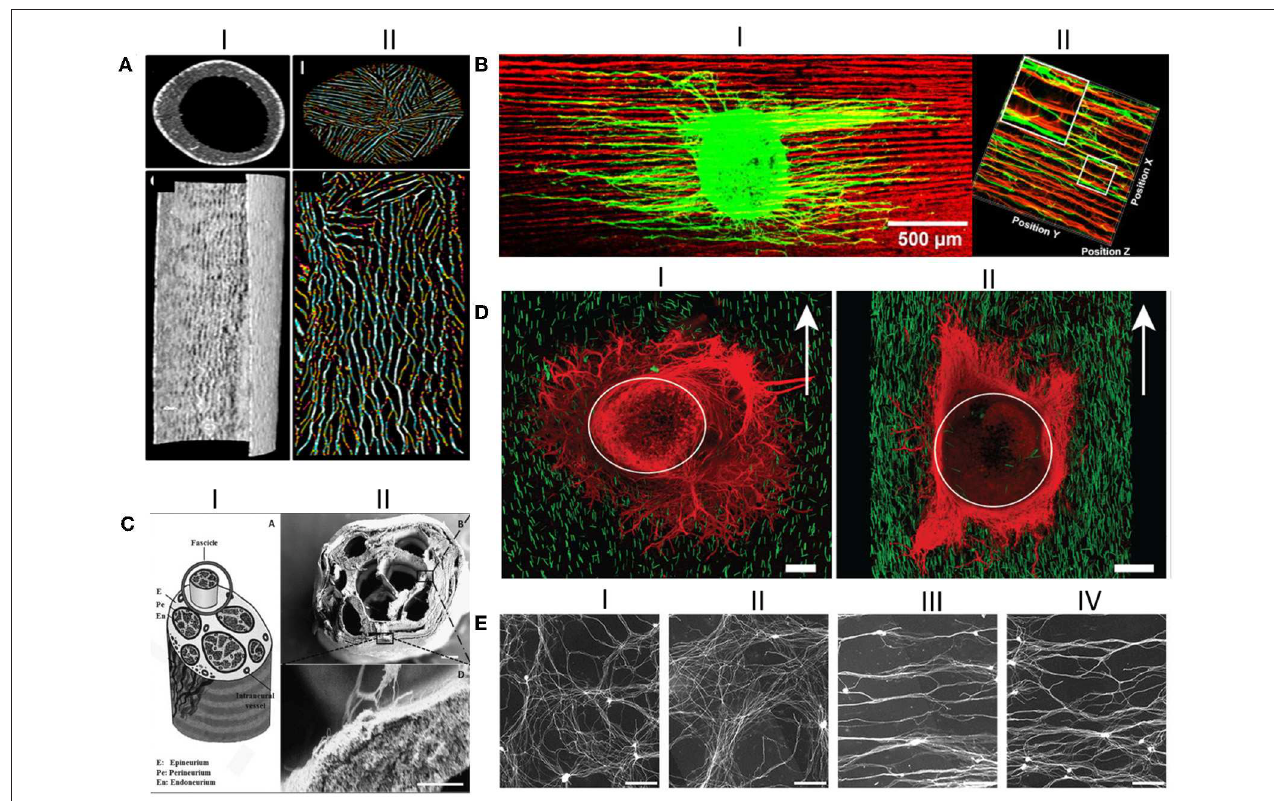
FIGURE 6 | Anisotropic guiding cues have been successfully produced as NGCs luminal fillers. (AI) Transverse and longitudinal Micro-CT sections of the hollow conduit; (AII) Transverse and longitudinal Micro-CT sections of the oriented chitosan-gelatin cryogel as luminal filler; (BI) DRG explants seeded on the longitudinal sections of the directionally orientated collagen-chitosan filler, where neurites align in the matrix; (BII) 3D reconstruction of axonal regeneration and Schwann cell migration on the orientated collagen-chitosan filler; (CI) Schematic drawing of the peripheral nerve structure; (CII) SEM micrograph of the produced silk fibroin NGC fabricated incorporating microchannels, which looks like the depicted schematic; Scale bar 200 µ m; (DI) DRG explants seeded in 0.25% volume of the anisogel, presenting isotropic structure, in which neurites do not orient; (DII) DRGs explants seeded in 1% anisogel in which neurites decide to orient; (E) Representative images of DRG explants neurites cultured on random patterns achieved with nanoimprinting lithography with metallic stampers made of three different spacings: (EI) on a flat surface; (EII) On a Blu-Ray disc spacing; (EIII) On a digital video disc spacing; and (EIV) On a compact disc spacing. Scale bar: 200 µ m. Figures have been reprinted and adapted from: (A) ( Singh et al., 2019), (B) (Huang L. et al., 2018), (C) (Dinis et al., 2015), (D) (Rose et al., 2017), and (E) (Huang L. et al.,